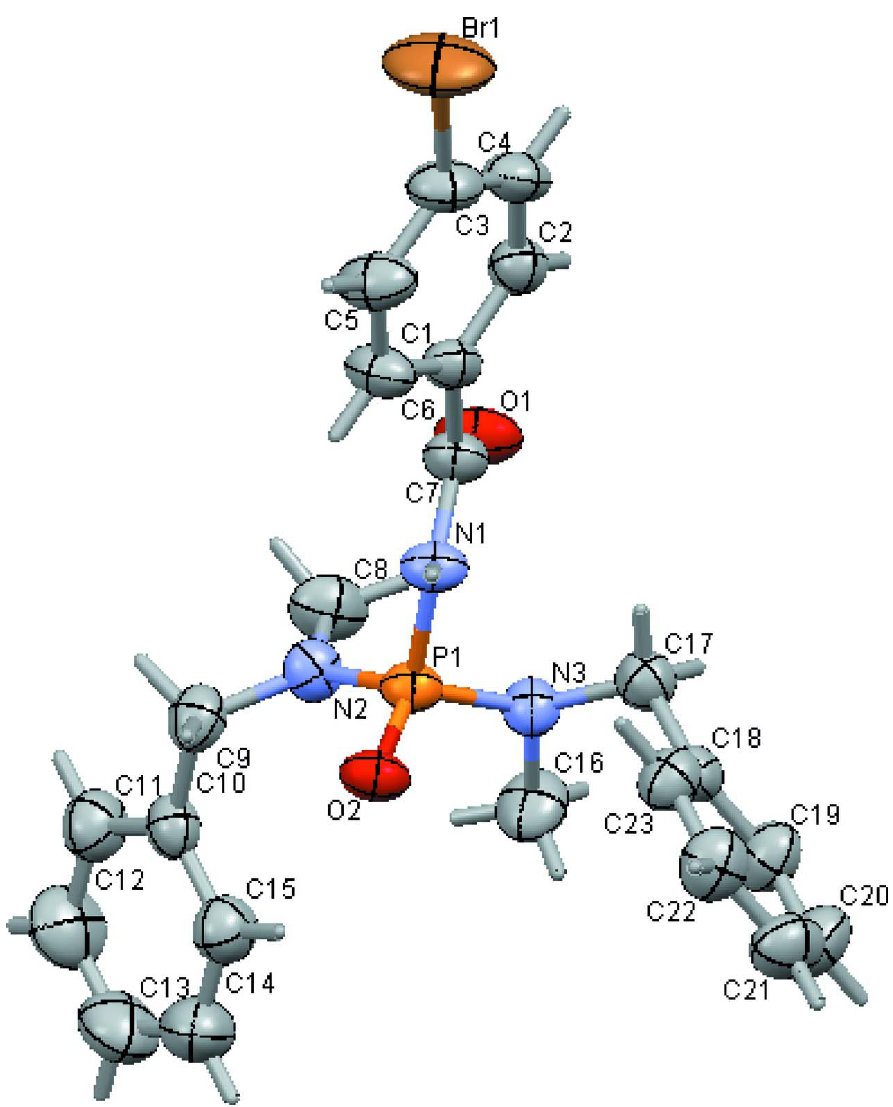
Figure 1 Molecular structure of I showing the atom-labelling scheme with thermal ellipsoids drawn at the 50% probability